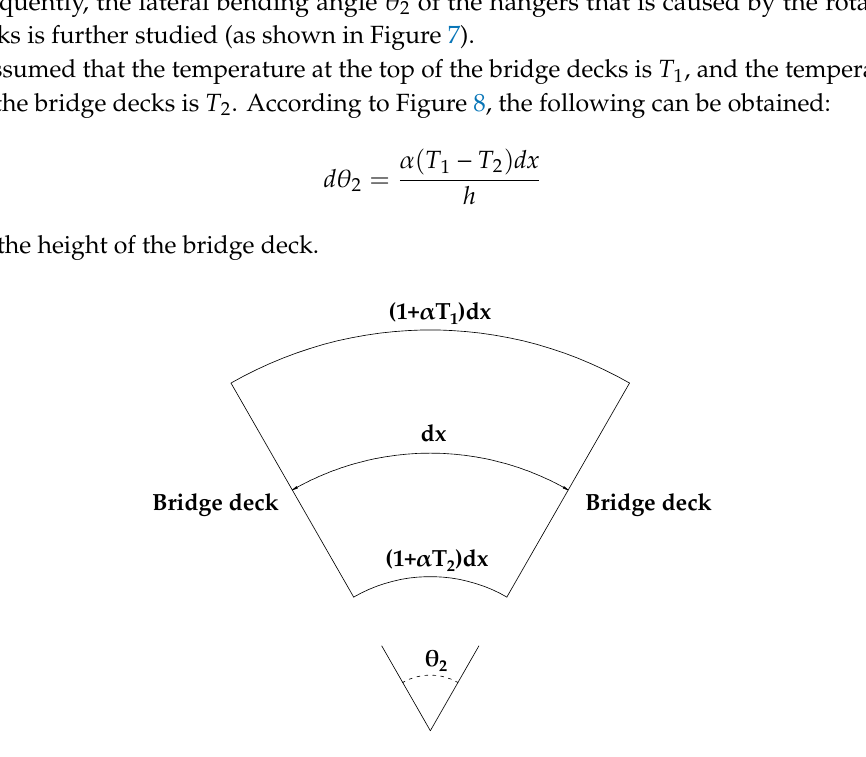
Figure 8. Rotation angle of the bridge decks.